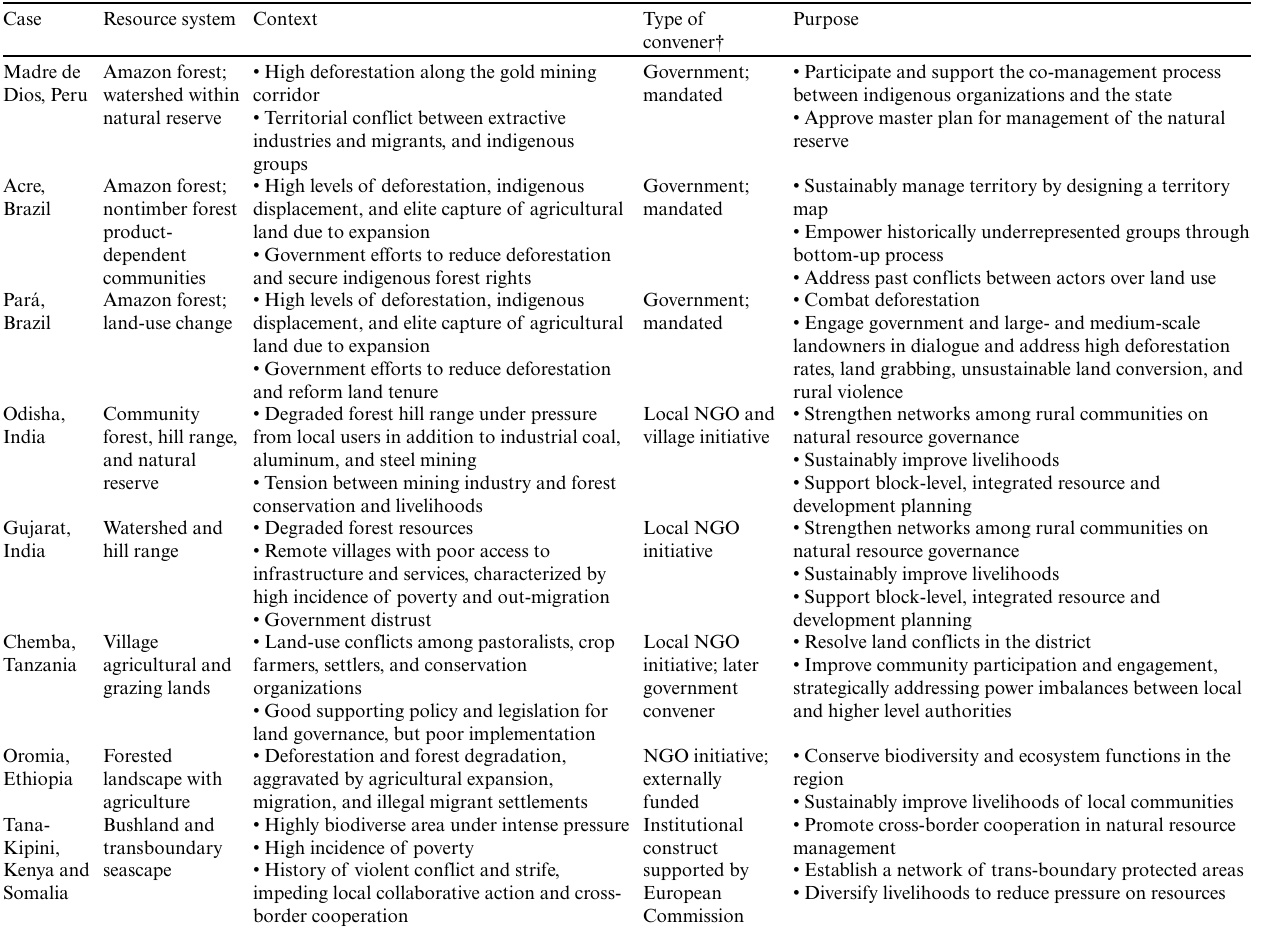
Table 1. Contexts and characteristics of the eight case study multistakeholder